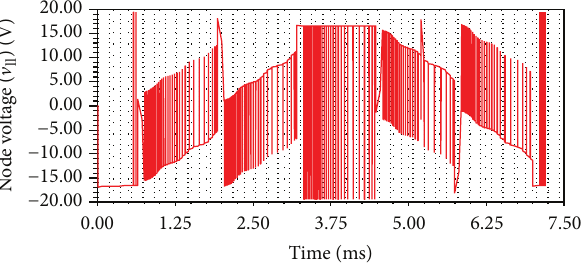
Figure 25: The line-to-line voltage waveform in hysteresis control mode (without filter).